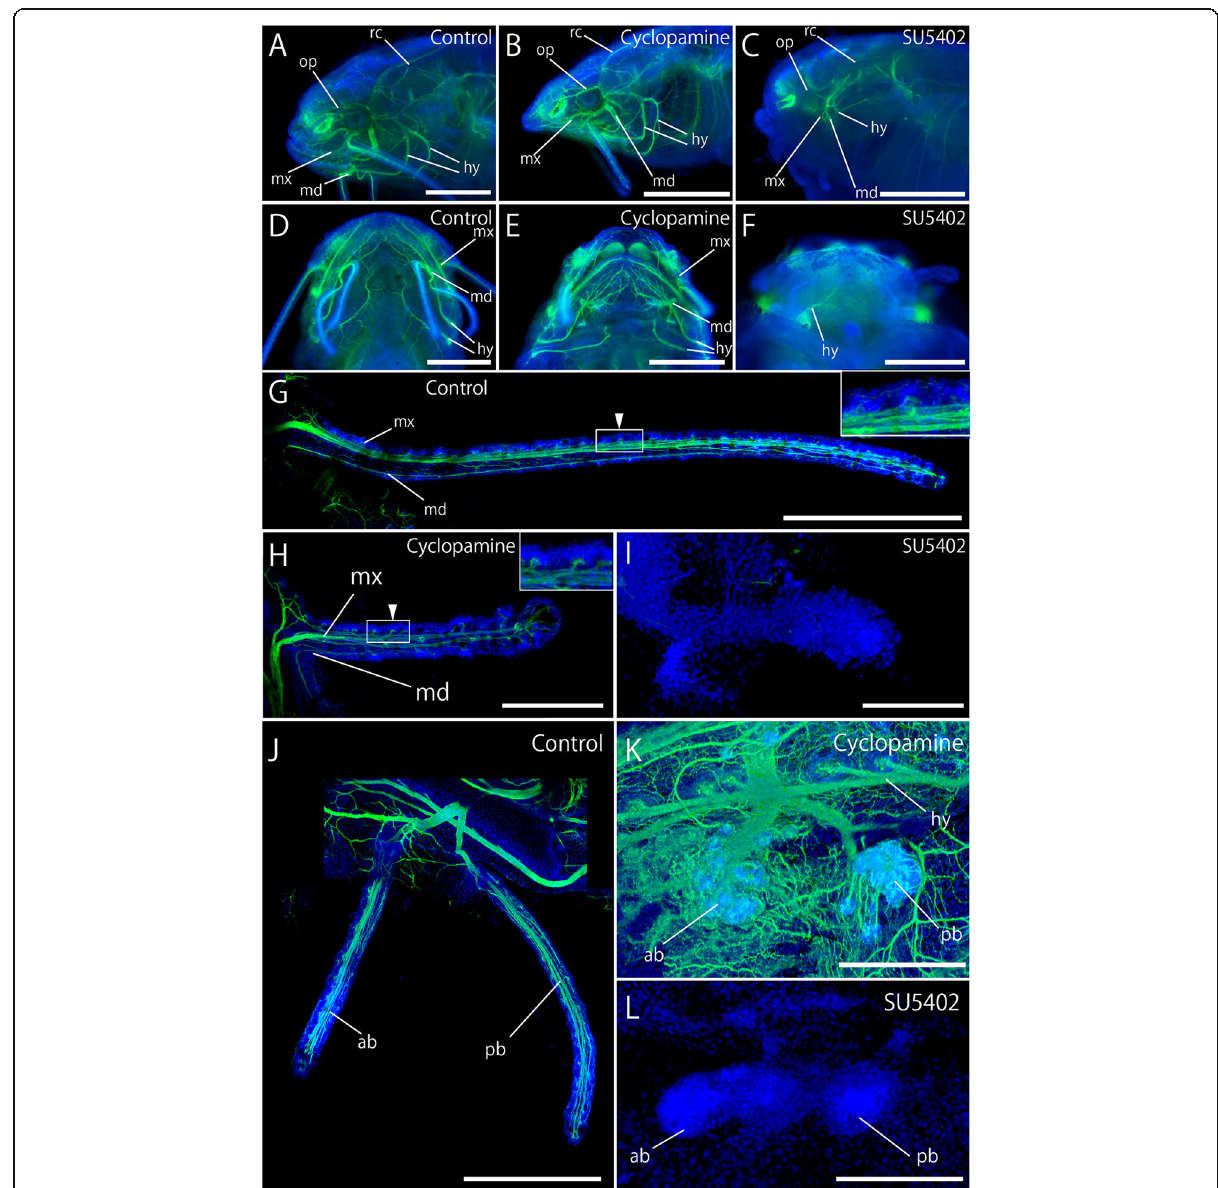
Fig. 7 Effects of SHH and FGF inhibitors on peripheral nerve morphology . Peripheral nerves (in green) were visualized by anti-acetylated tubulin antibody. Blue staining shows nucleus labeled by DAPI. a – c are lateral and ( d – f ) are ventral. Cyclopamine-treated embryos ( b , e ) represented apparently normal distribution of peripheral nerves compared with the control group ( a , d ), although their mandibular regions became smaller and mandibular barbels were absent. However, with SU5402 treatment, peripheral nerve axons were poorly developed ( c , f ). g – l effects of SHH and FGF inhibitors on the peripheral nerves in the maxillary ( g – i ) and mandibular ( j – l ) barbels of Amur catfish. Insets in g, h indicate high magnification images of boxes in g , h . In the control group at 5 dpf ( g ), peripheral nerves (mx and md) extended normally and reached the distal end of the barbel. In the cyclopamine-treated embryos, both mx and md entered into the maxillary and mandibular barbels and reached the distal end, consistent with the control group, although the length of the barbels shortened ( h , k ). However, with SU5402 treatment, the peripheral nerves failed to enter the barbels ( i , l ). ab, anterior mandibular barbel ramus of trigeminal and facial nerves; hy, hyoid ramus of facial and anterior lateral line nerves; md, mandibular ramus of trigeminal and facial nerves; mx, maxillary ramus of trigeminal and facial nerves; op, ophthalmic ramus of trigeminal and facial nerves; pb, posterior mandibular barbel ramus of trigeminal and facial nerves; rc, recurrent ramus of the facial nerve. Anterior is left in a – c and the upper side in d – f . In g , left and upper sides show proximal and anterior sides, respectively. In h and i, left and upper sides show distal and anterior sides, respectively. In j – l , upper and left sides show proximal and anterior sides, respectively. Scale bars in a – g and j are 500 μ m, 400 μ m in H, and 200 μ m in i , k , and